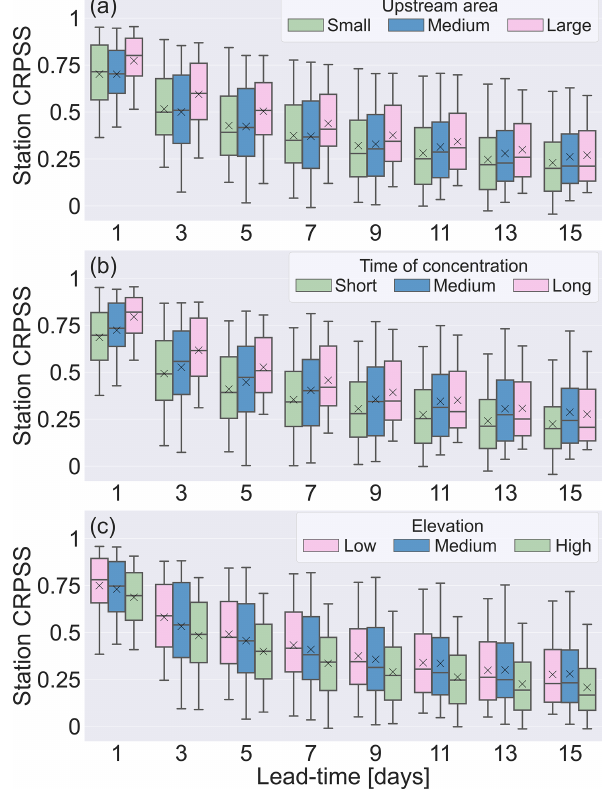
Figure 13. The CRPSS for all 522 stations at every other lead time with stations categorised by their catchment characteristics. (a) Up- stream area. Small catchments: less than 1000km 2 (165 stations). Medium catchments: between 1000 and 5000km 2 (204 stations). Large catchments: larger than 5000km 2 (153 stations). (b) Time of concentration. Fast-response catchments: less than 24h (253 sta- tions). Medium-response catchments: between 24 and 48h (144 sta- tions). Slow-response catchments: more than 48h (126 stations). (c) Elevation. Low-elevation catchments: less than 150m (178 sta- tions). Medium-elevation catchments: between 150 and 400m (168 stations). High-elevation catchments: more than 400m (177 sta-